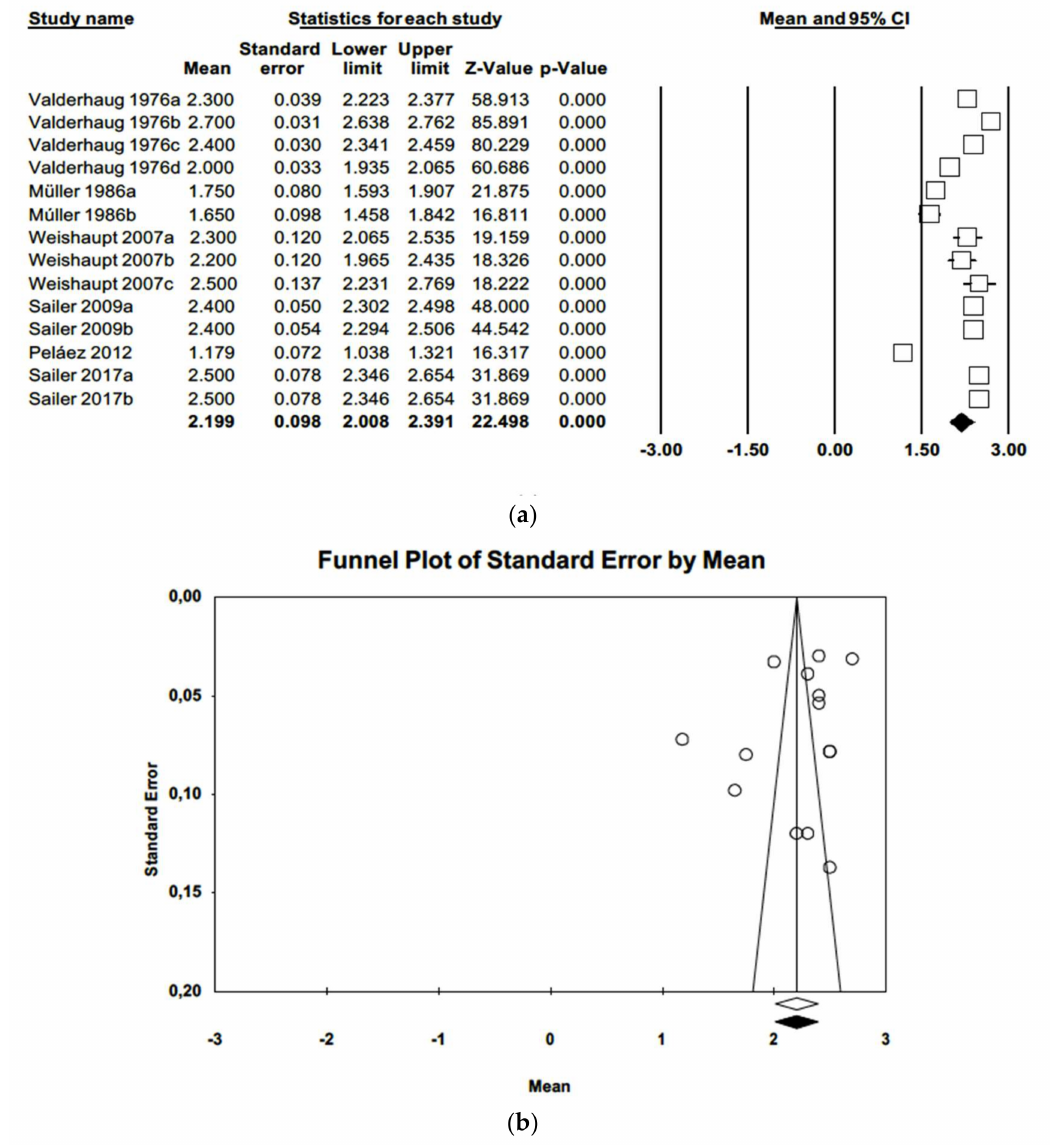
Figure 6. ( a ) Forest plot of periodontal probing depth meta-analysis. ( b ) Funnel plot with observed and imputed